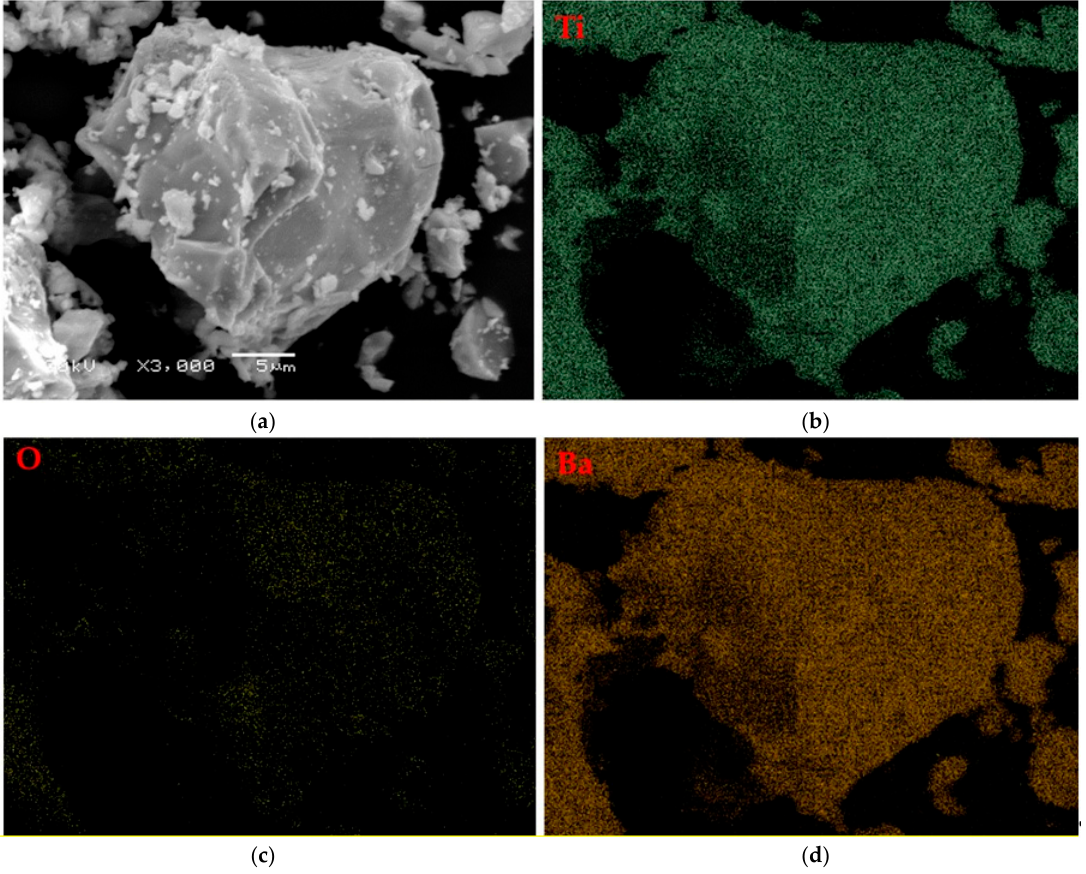
Figure 7. SEM − EDS elemental mapping for BaTiO 3 : SEM image ( a ) and the corresponding SEM mapping of titanium ( b ), oxygen ( c ) and barium ( d ).